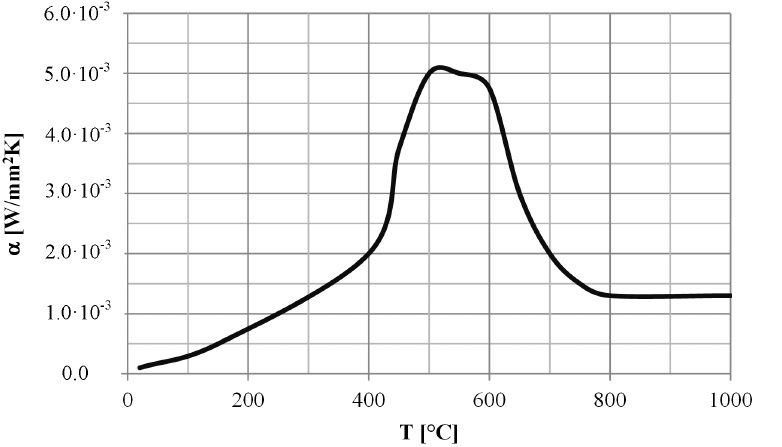
Figure 4. Temperature-dependent heat transfer coefficient between the outer surface of the starter clutch barrel and the surrounding medium considered during the